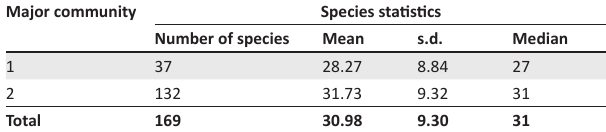
TABLE 1: Species richness for the major plant communities on Platberg.